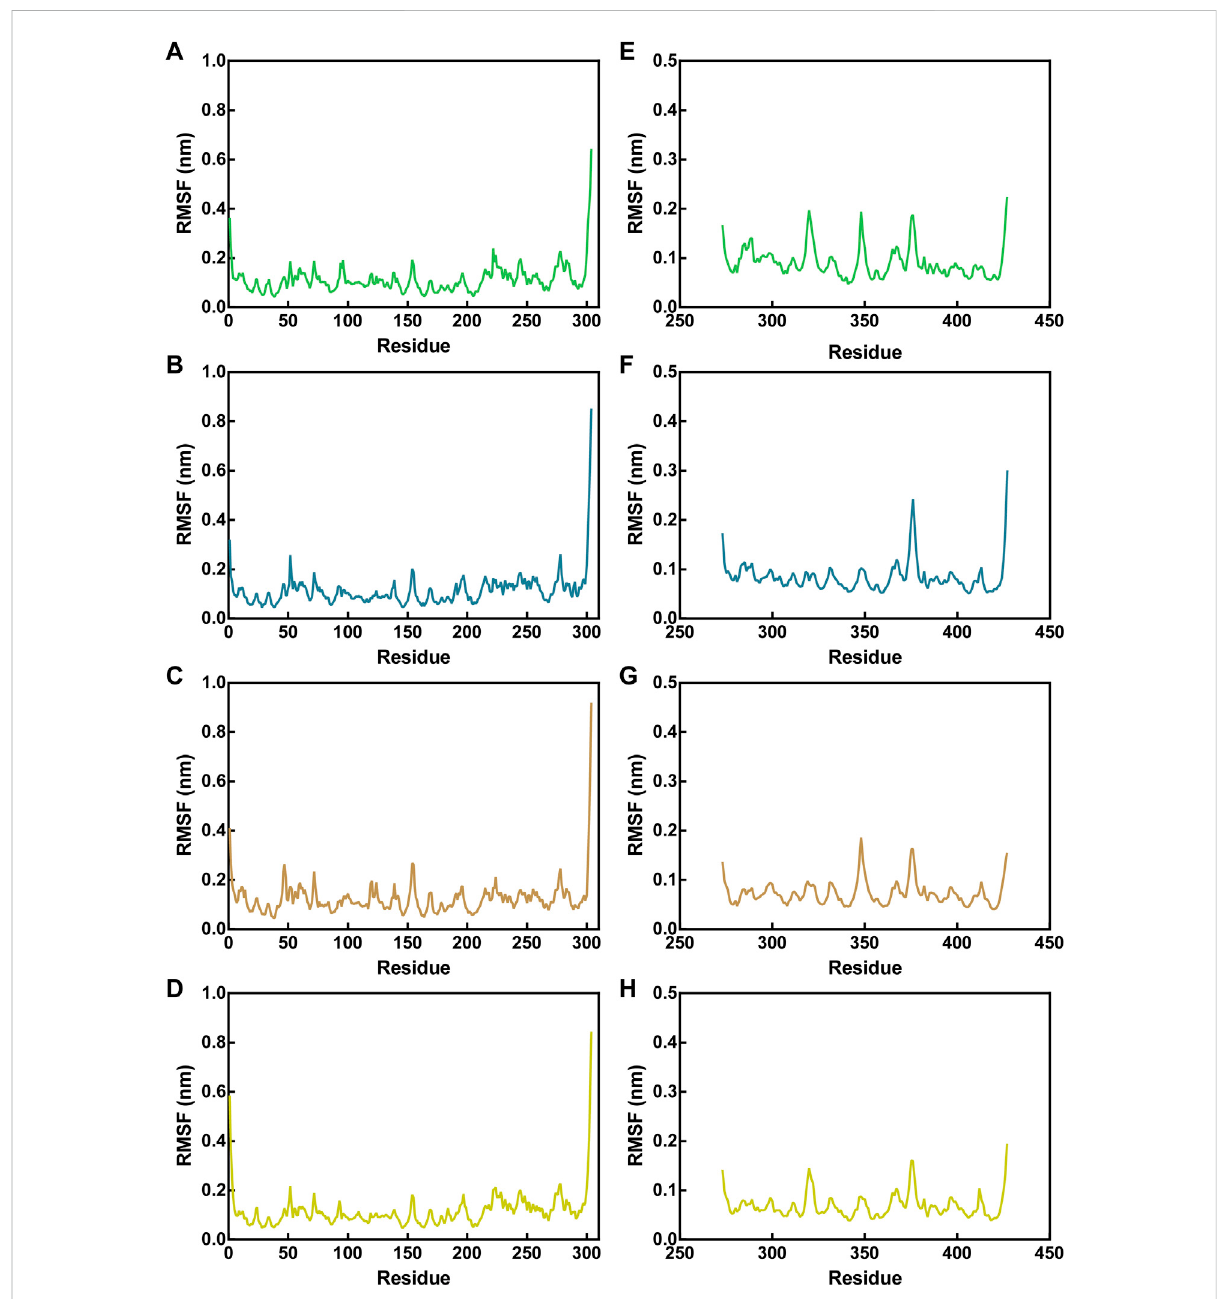
FIGURE 6 RMSFofC α atomsofMproresiduesinMpro-peptidecomplexes (A – D) andNRP1inNRP1-peptidecomplexes (E – H) .Inallpanelsthecolorcode is MN-1 (green), MN-2 (blue), MN-3 (brown), and MN-4